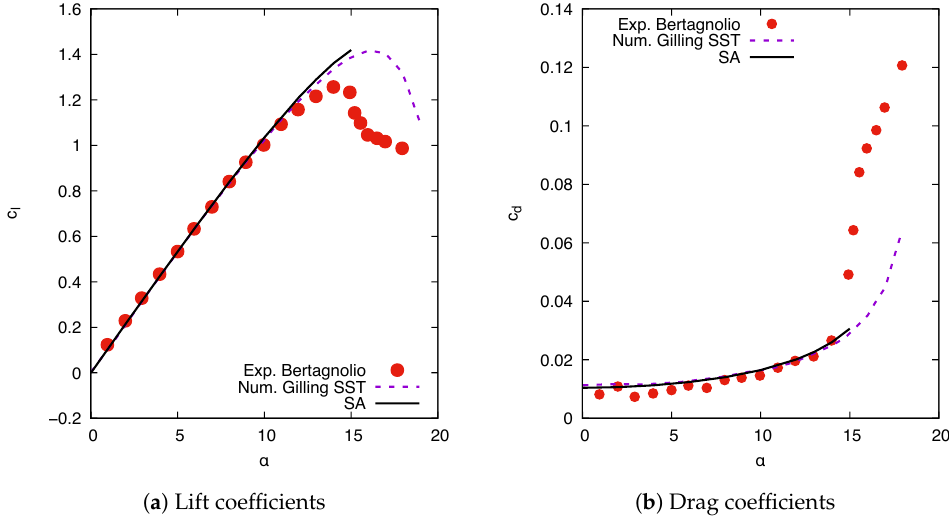
Figure 5. Lift and drag coefficients comparison between CFD results and experiments for the NACA 0015 at Re = 1.6 × 10 6 . Legend applies to ( a , b ).